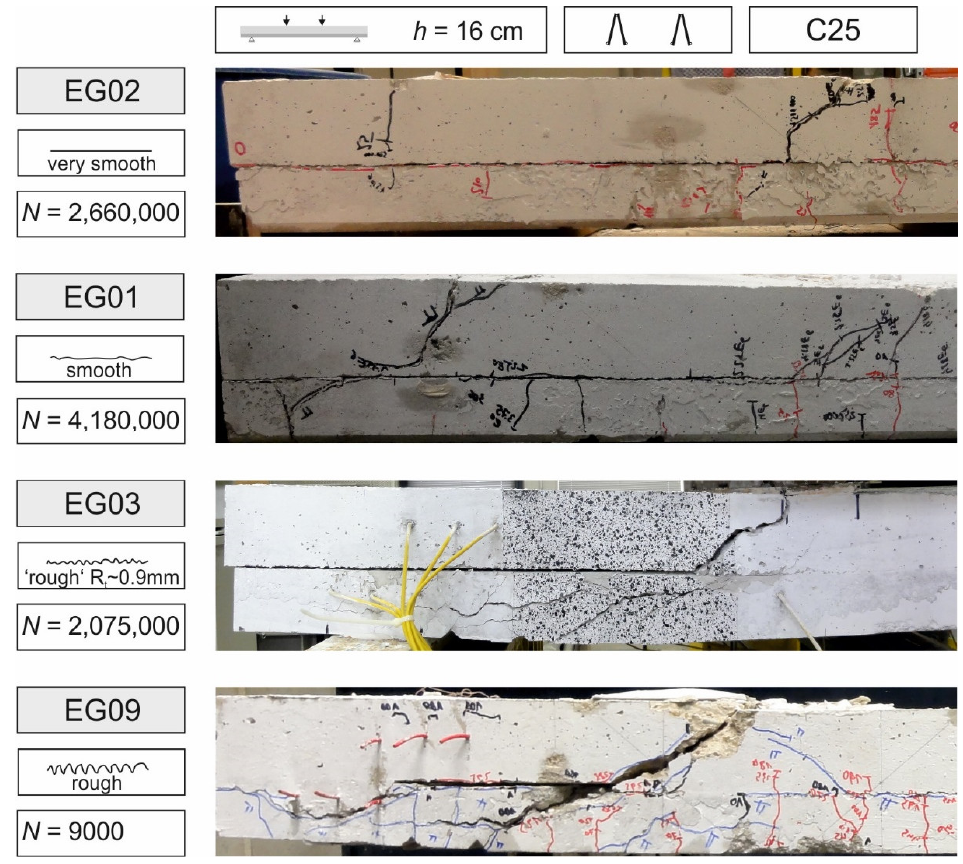
Figure 16. Influence of interface roughness: crack patterns of Specimens EG01, EG02, EG03, and EG09.